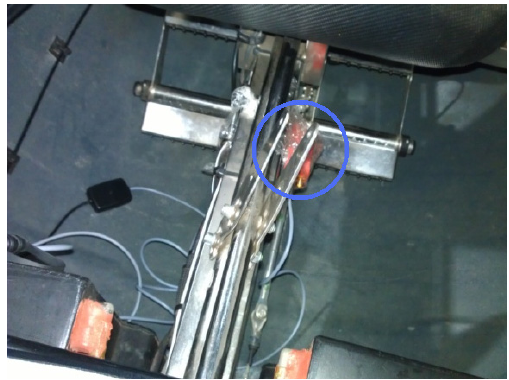
Figure 3. Position of the last IMU shown within the blue